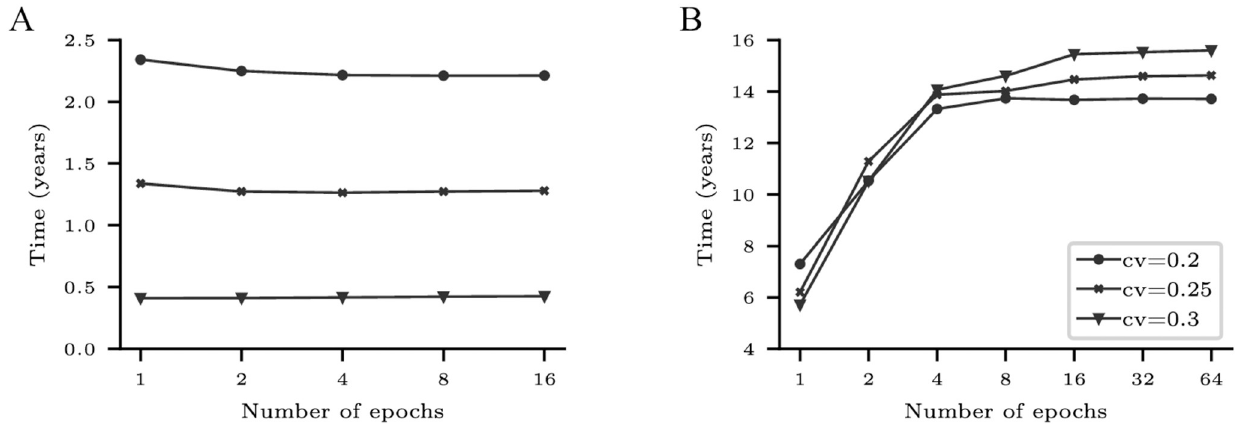
Fig 10. Forecasted T 50 C (in years) as a function of the number of epochs for frame disabling (A) and L2C2 (B) caches. Three coefficients of variation are employed: cv = 0.2, 0.25, and 0.3.